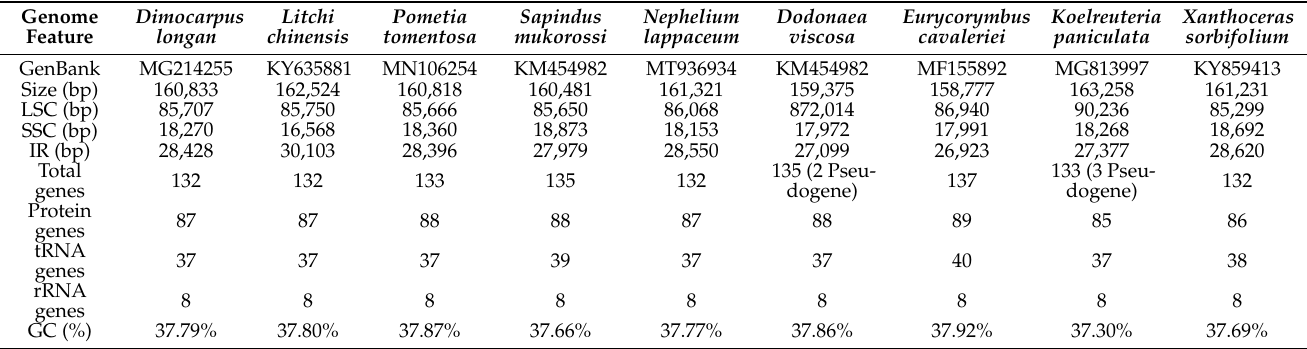
Figure 1. Gene map of N. lappaceum chloroplast genome. Genes drawn outside and inside of the circle are transcribed clockwise and counterclockwise, respectively. Genes belonging to different functional groups are color coded. The darker gray in the inner circle corresponds to GC content. Small single-copy (SSC) region, large single-copy (LSC) region, and inverted repeats (IRA and IRB) are indicated. Table 1. Comparison of the general features of the nine Sapindaceae chloroplast